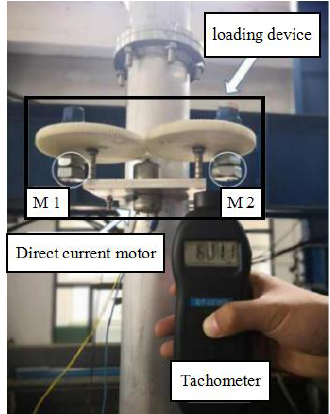
Figure 4. Cyclic loading device.